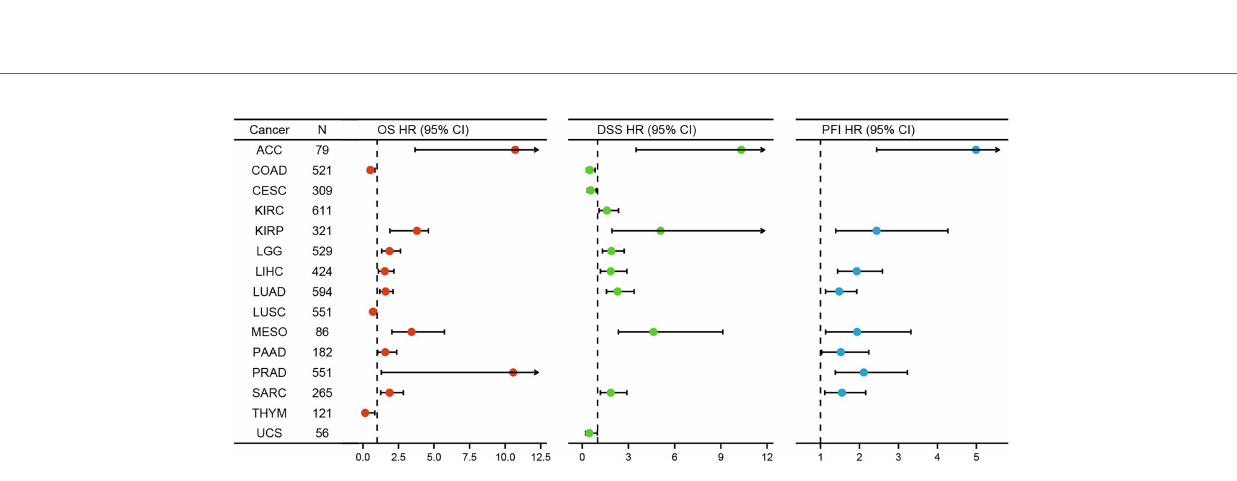
FIGURE 3 | Receiver Operator Characteristic (ROC) curve of HELLS in 14 Cancers. Cancers with AUC > 0.9 for HELLS: (A) BLCA, (B) BRCA, (C) CESC, (D) CHOL, (E) COAD, (F) ESCA, (G) LAML, (H) LICH, (I) LUAD, (J) LUSC, (K) PAAD, (L) READ, (M) STAD, (N) UCS.